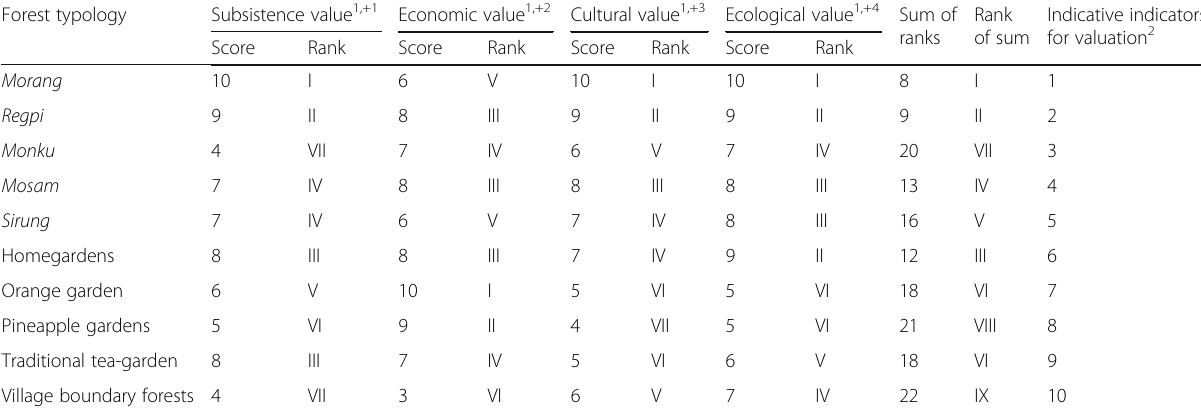
Table 2 Qualitative assessment of diverse values of varied local forests as perceived by the Adi tribe Forest